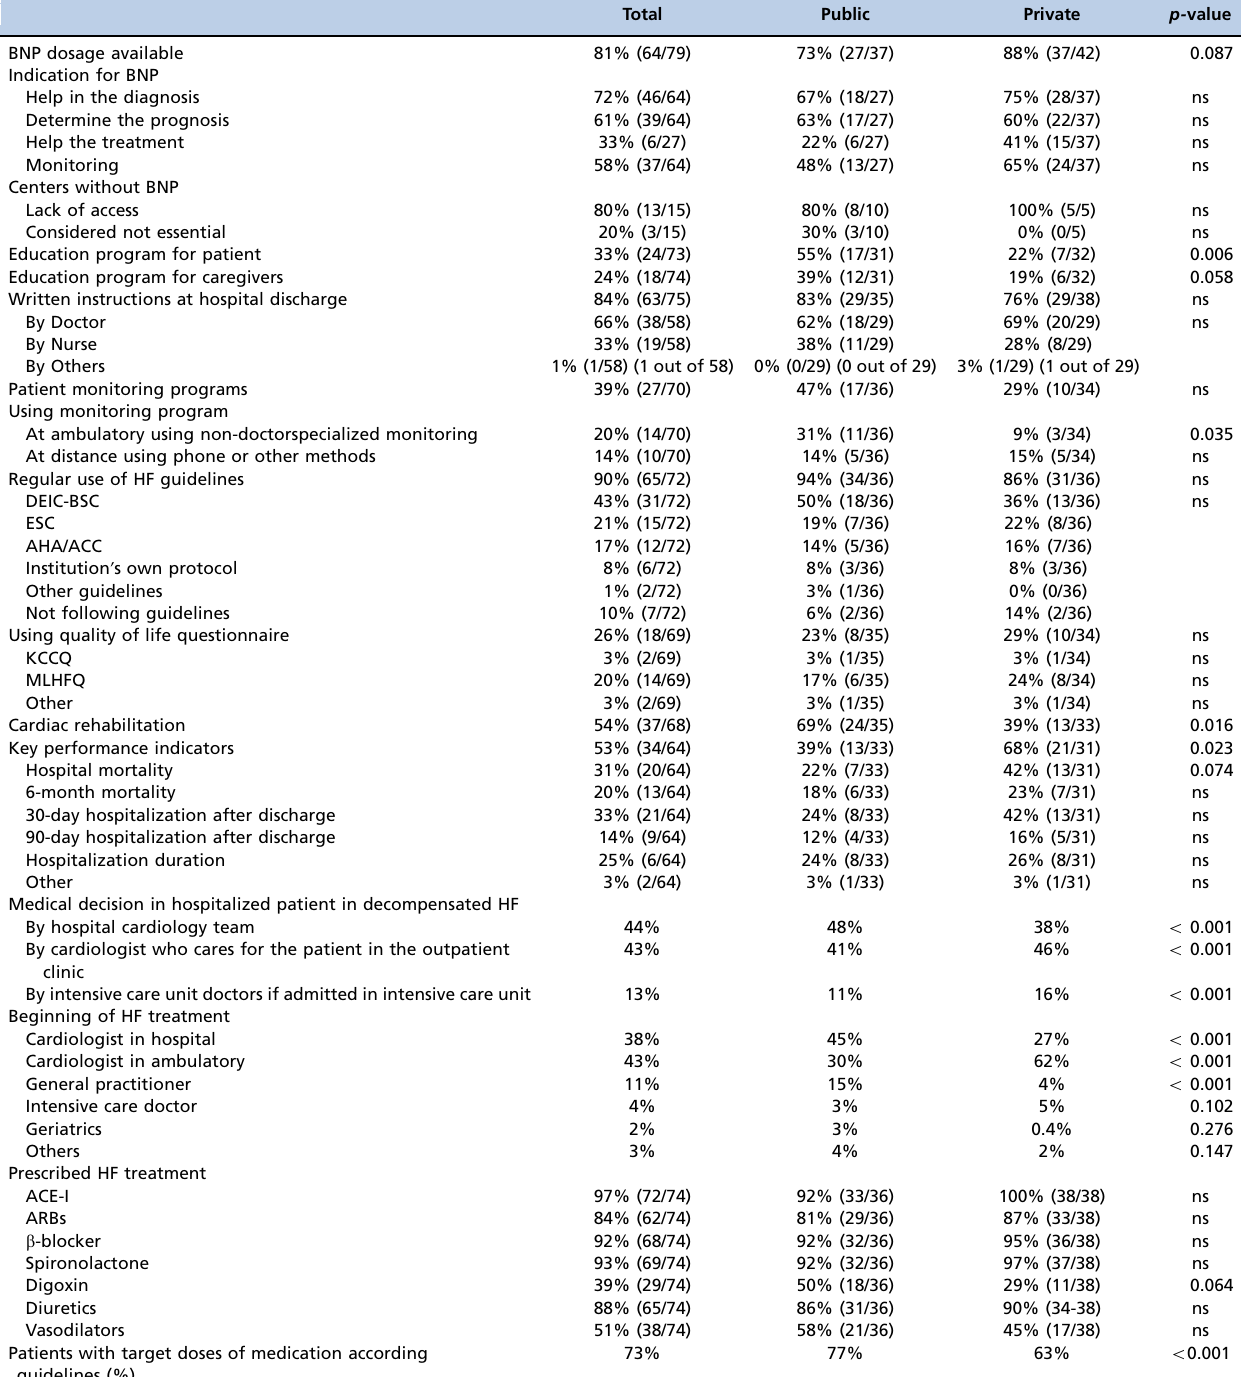
Table 2 - Delivered Care for Heart Failure Patients Comparing Public versus